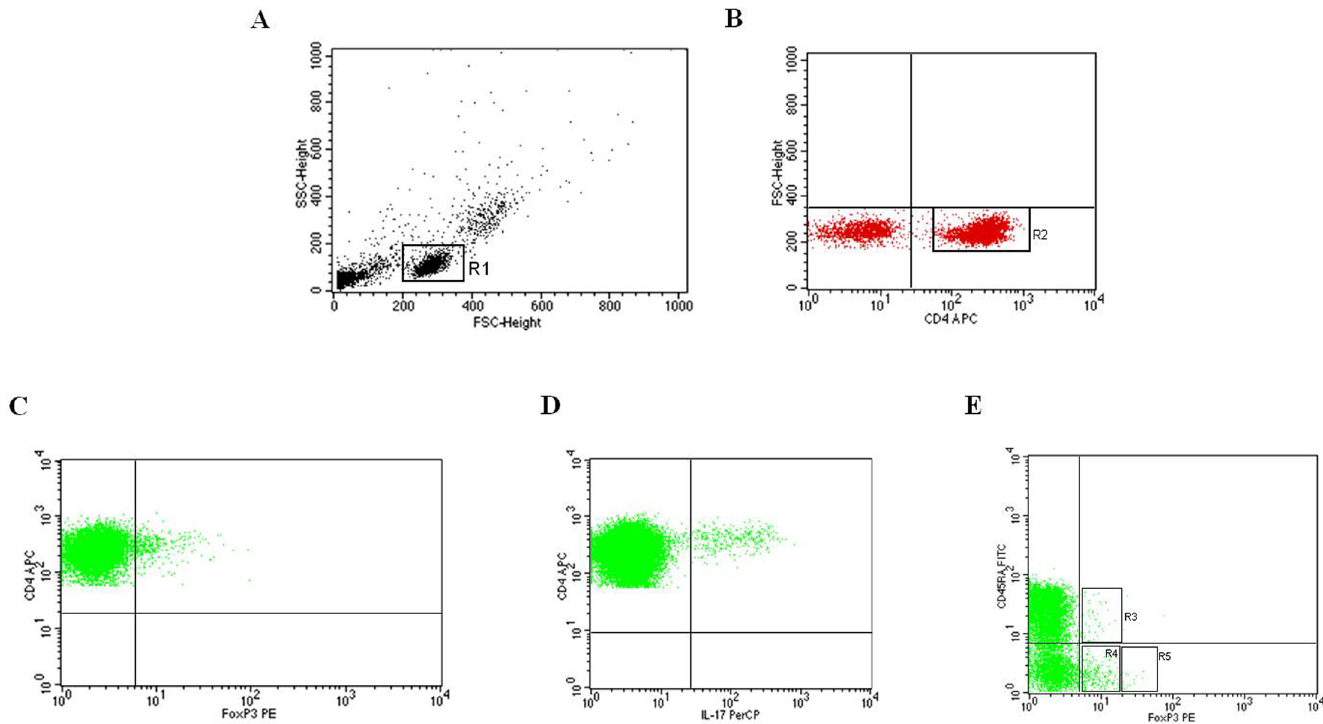
Fig 1. Representative dot plots of peripheral blood lymphocytes from one patient showing the gating strategyto identify Th17 and Treg cells. (A) Live cells, gated for cell death and debris exclusion,were then gated as lymphocytes (R1) basedon morphological parameters (SSC, side scatter; FSC, forward scatter). (B) Identification of CD4+ lymphocytes (R2) within the R1 population.(C) Identification of Treg cells and (D) Th17 cells within the R2 population. (E) Identification of the I, II and III fractions of Treg cells within the R2 population.The values were expressedas percentage of CD4+ T cells.